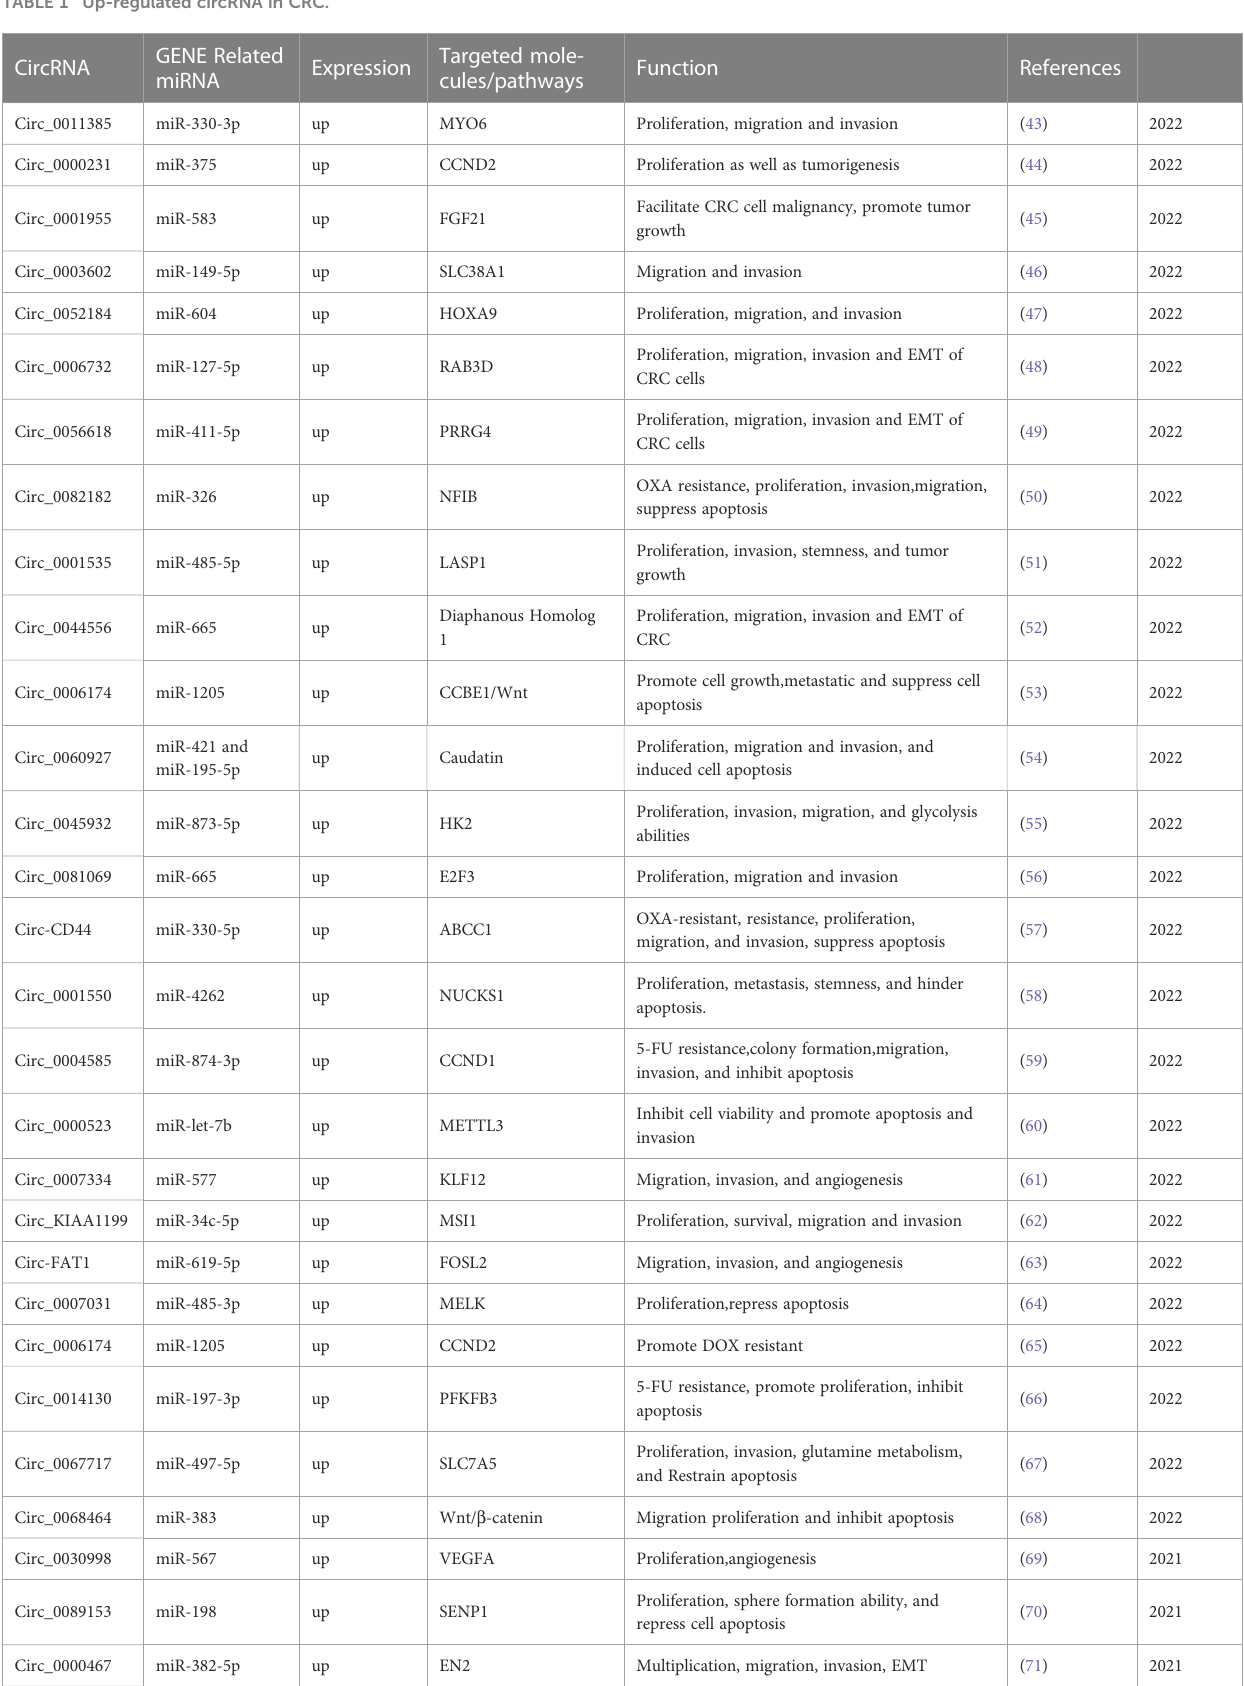
TABLE 1 Up-regulated circRNA in